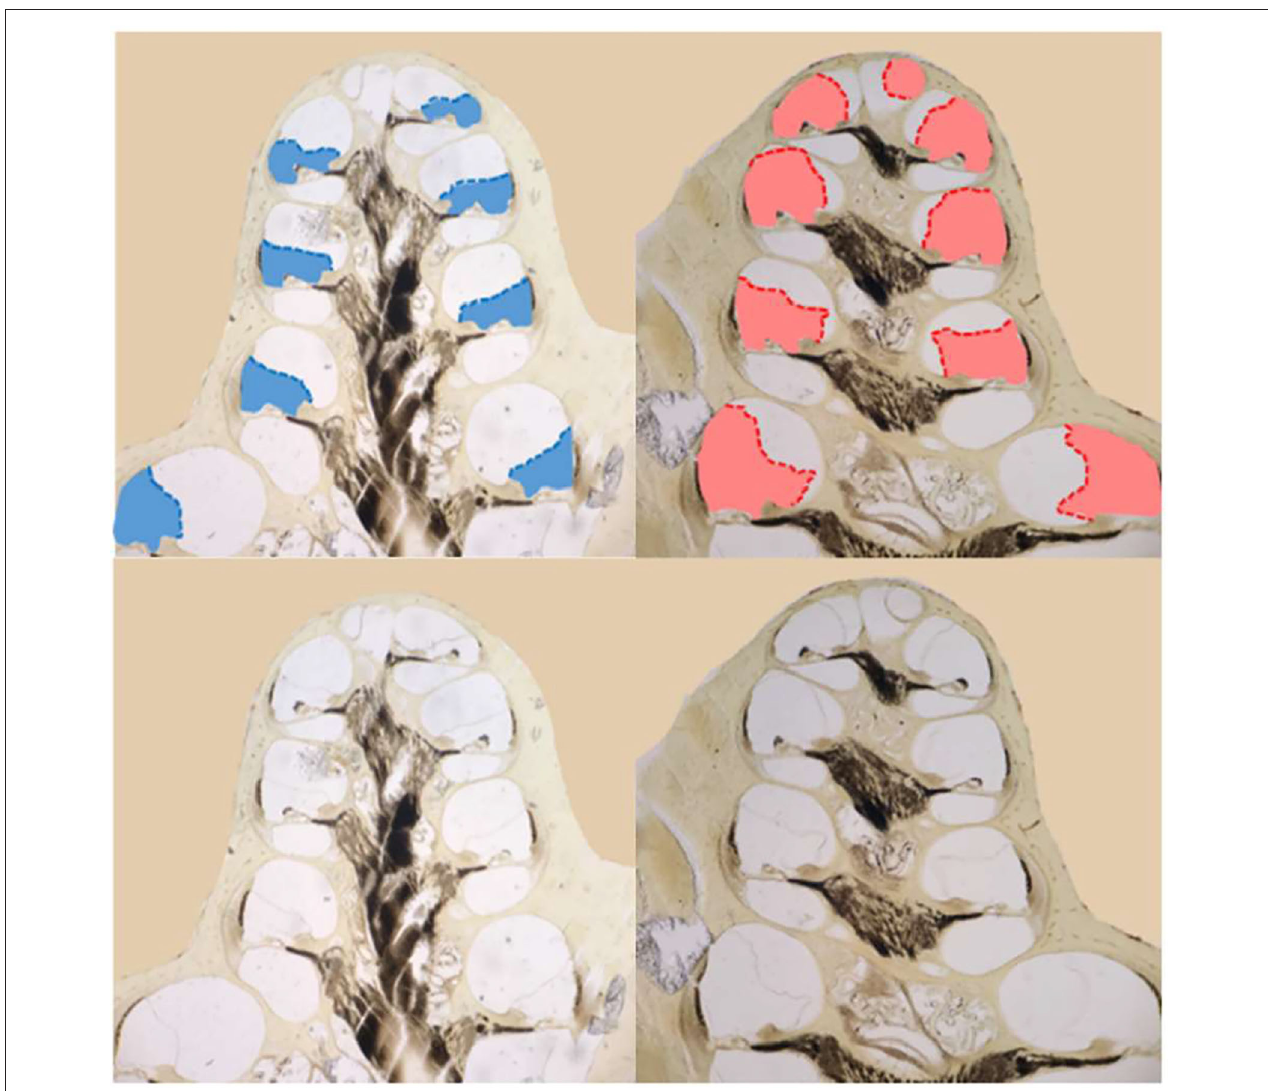
FIGURE 6 | Images of mid-modiolar sections from a guinea pig that survived 30 days after a surgery to ablate the endolymphatic sac on the right side. The scala media of the right cochlea (right column) was enlarged (red) compared to that in the normal left side (left column) scala media (blue). The scala-media areas are shown in color at top and, from the same cochleae, uncolored at